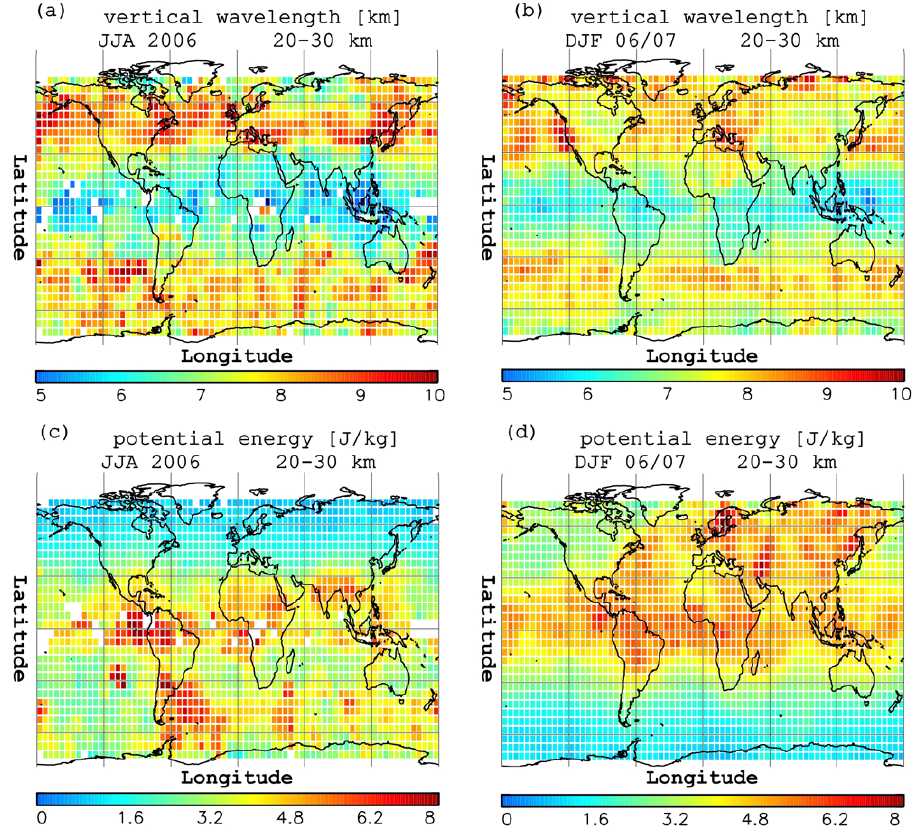
Fig. 9. Vertical wavelength derived from COSMIC for the available 3-point groupings (JJA 2006) ( a ) and (DJF 2006/07) ( b ), and the mean potential energy distribution for each season ( c and d ) for the altitude range of